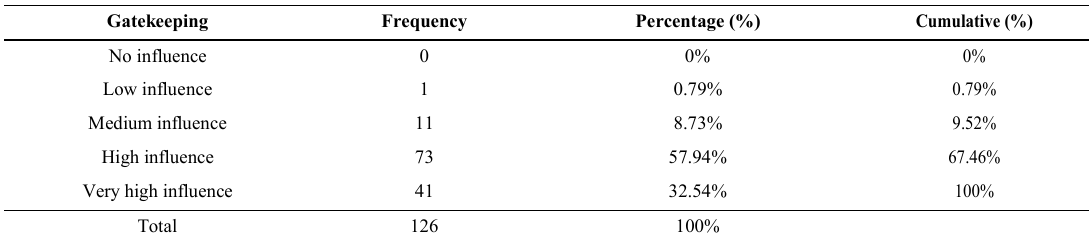
Table 2. Gatekeeping.